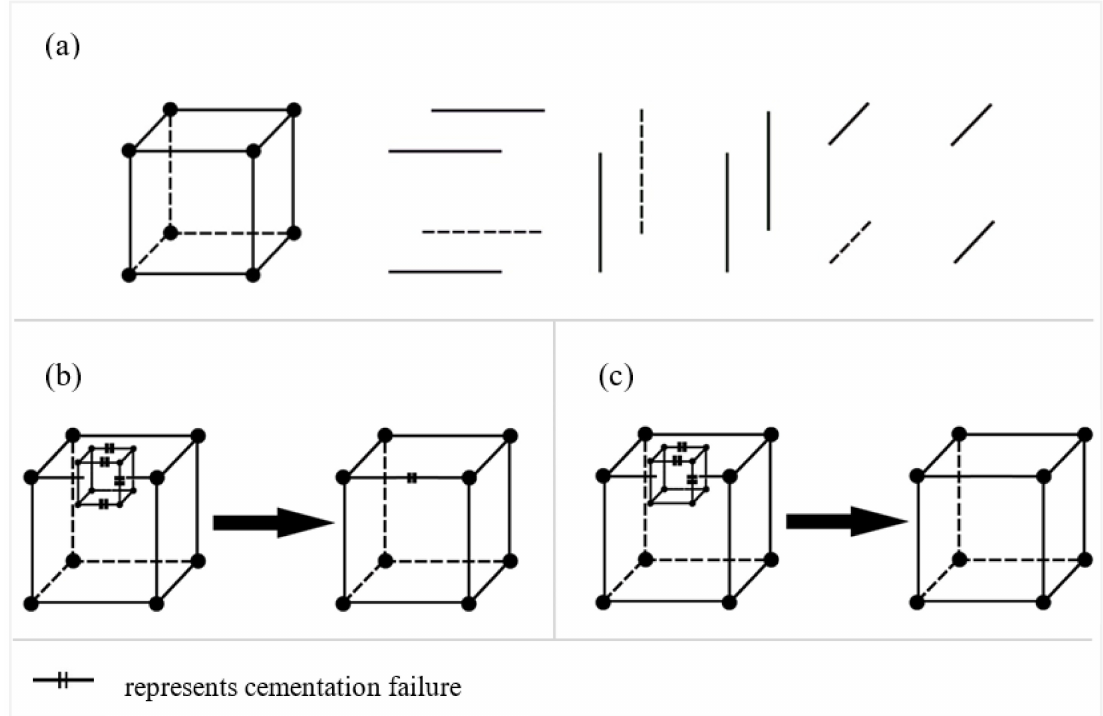
Figure 3. Schematic diagram of a soft rock renormalization transformation rule: ( a ) units and cements, ( b ) damage, ( c )